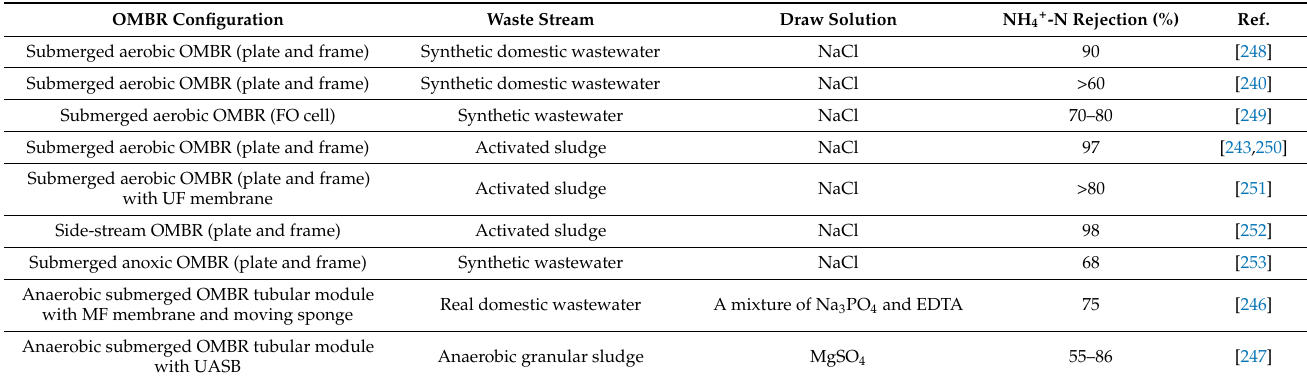
Figure 11. OMBR configurations: ( a ) submerged aerobic OMBR with draw solution regeneration unit, ( b ) submerged aerobic OMBR with open loop draw solution, ( c ) side-stream anaerobic OMBR for biogas production, ( d ) side stream aerobic OMBR with draw solution regeneration unit and ( e ) aerobic OMBR with draw solution regeneration unit and salt leak membrane system (MF/UF). Reprinted from Wang et al. [176], copyright (2016) with permission from Elsevier. Table 6. Summary of recent literature for nitrogen recovery with FO process.